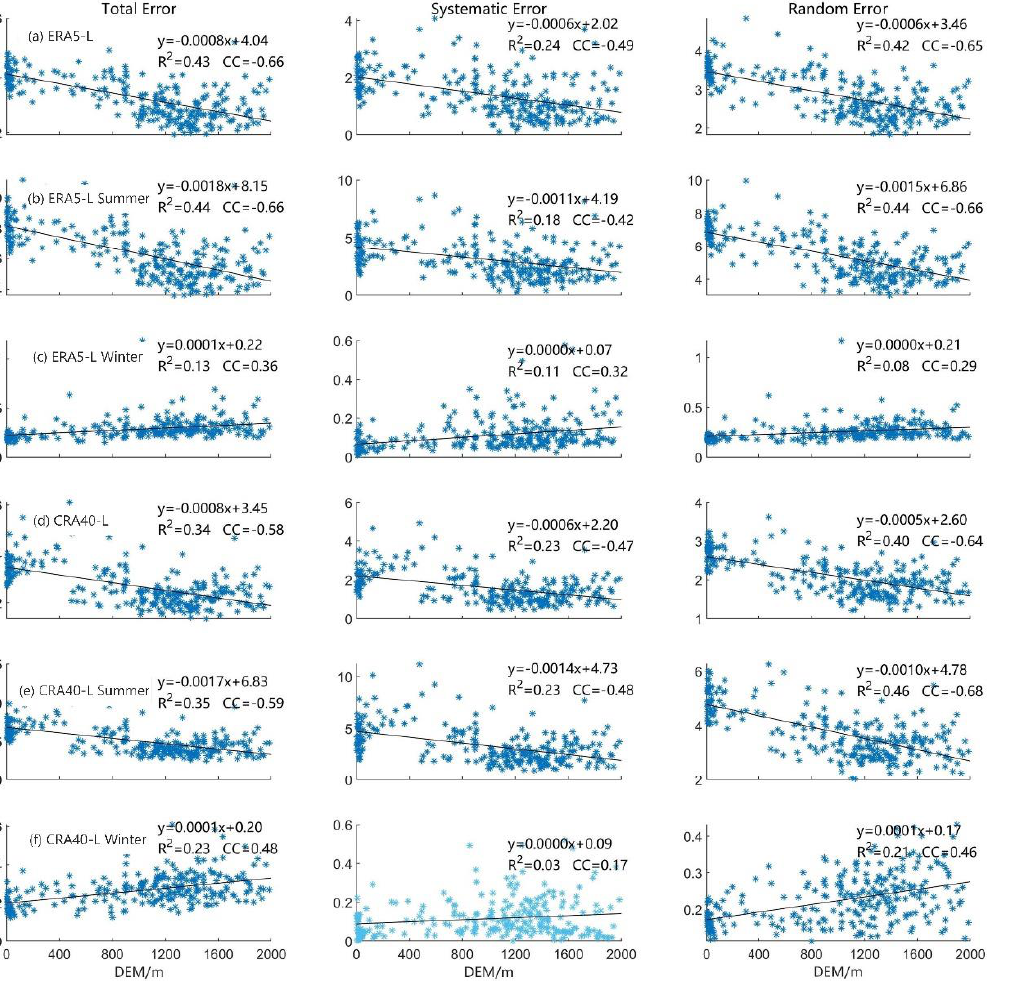
comprised mainly summer precipitation. Therefore, a stronger elevation – error correlation was observed for CRA40-Land in summer and ERA5-Land in winter. 4.3. Hit, Missed, and False Bias 4.3.1. Spatiotemporal Variations in Different Seasons Given a precipitation field, it is necessary to derive a precipitation event mask based on a rain/no rain threshold. In a study by Tian et al. [22], the threshold was set to 1 mm/d. However, this threshold value would have ignored 365 mm of precipitation per year un- der ideal conditions. Therefore, the rain/no rain threshold was set to 0.1 mm/d in this study.